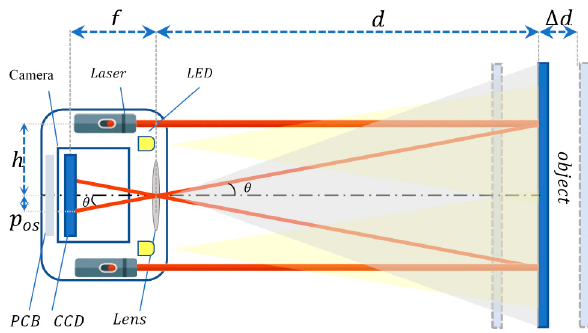
Figure 1. Laser triangulation geometry principle for distance determination.